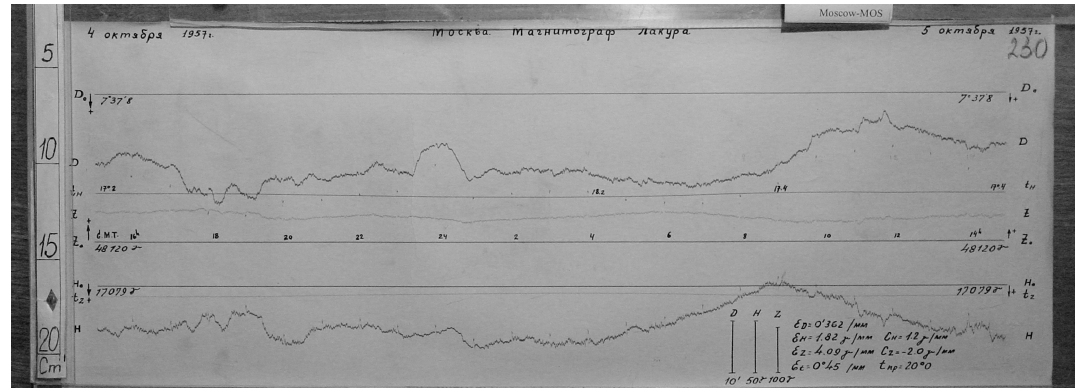
Figure 10. Photocopy of the daily magnetogram (magnetic vector components D , H , Z ) registered on 4 October 1957 at geomagnetic observatory Moscow (IAGA-code: MOS) using standard La Cour recorder (World Data Center for Solar-Terrestrial Physics, http://www. wdcb.ru/geomscan/Historic/Cor/MOS/MOS57/MOS19571004.JPG, last access: 12 August